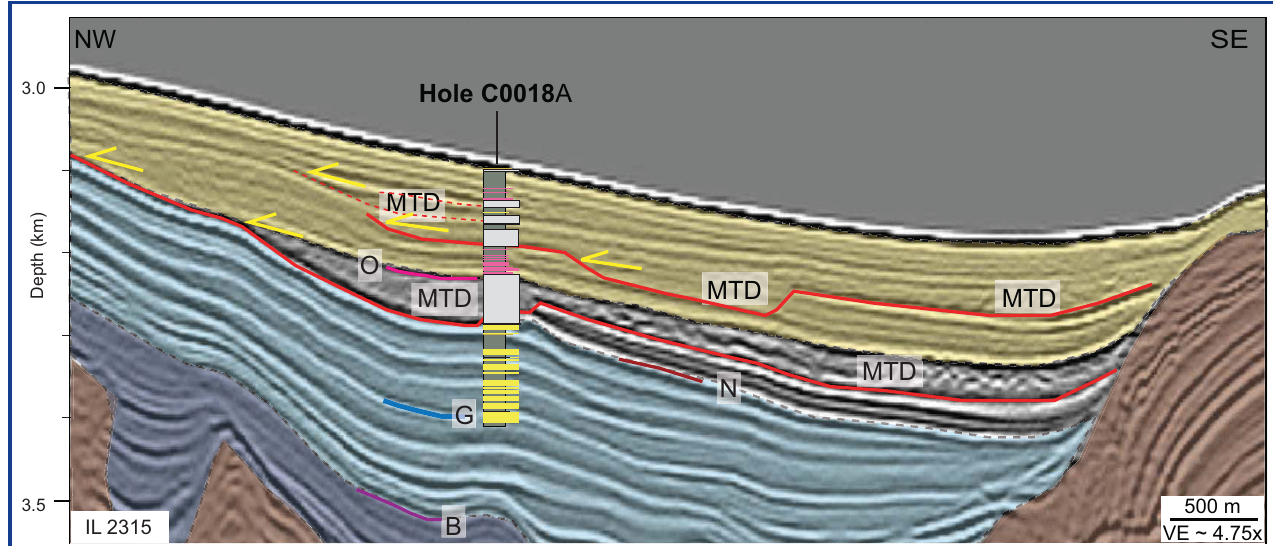
Figure 6. Lithology of Site C0018 on seismic profile. IL=in-line, VE=vertical exaggeration. Key seismic horizons are labeled B, G, N, and O MTD=mass transport deposit. Figure modified after Strasser et al.